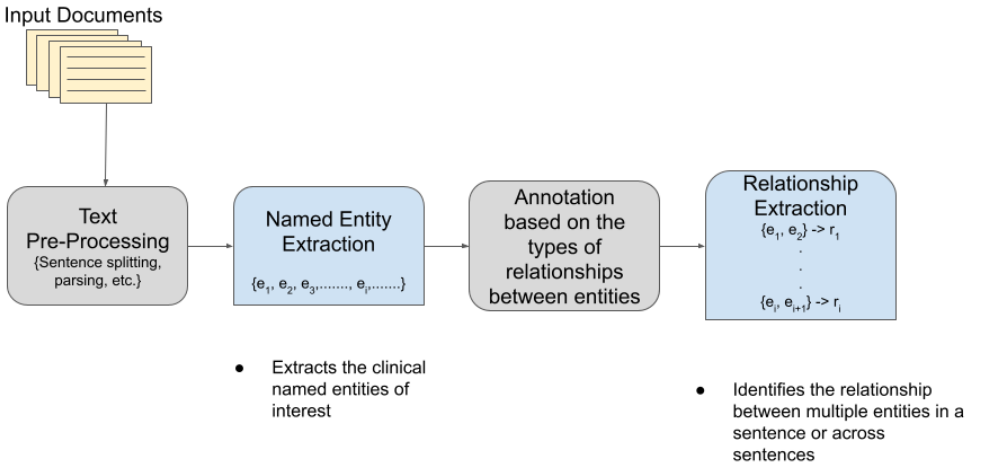
Figure 1. Association between Named Entity Recognition and Relationship